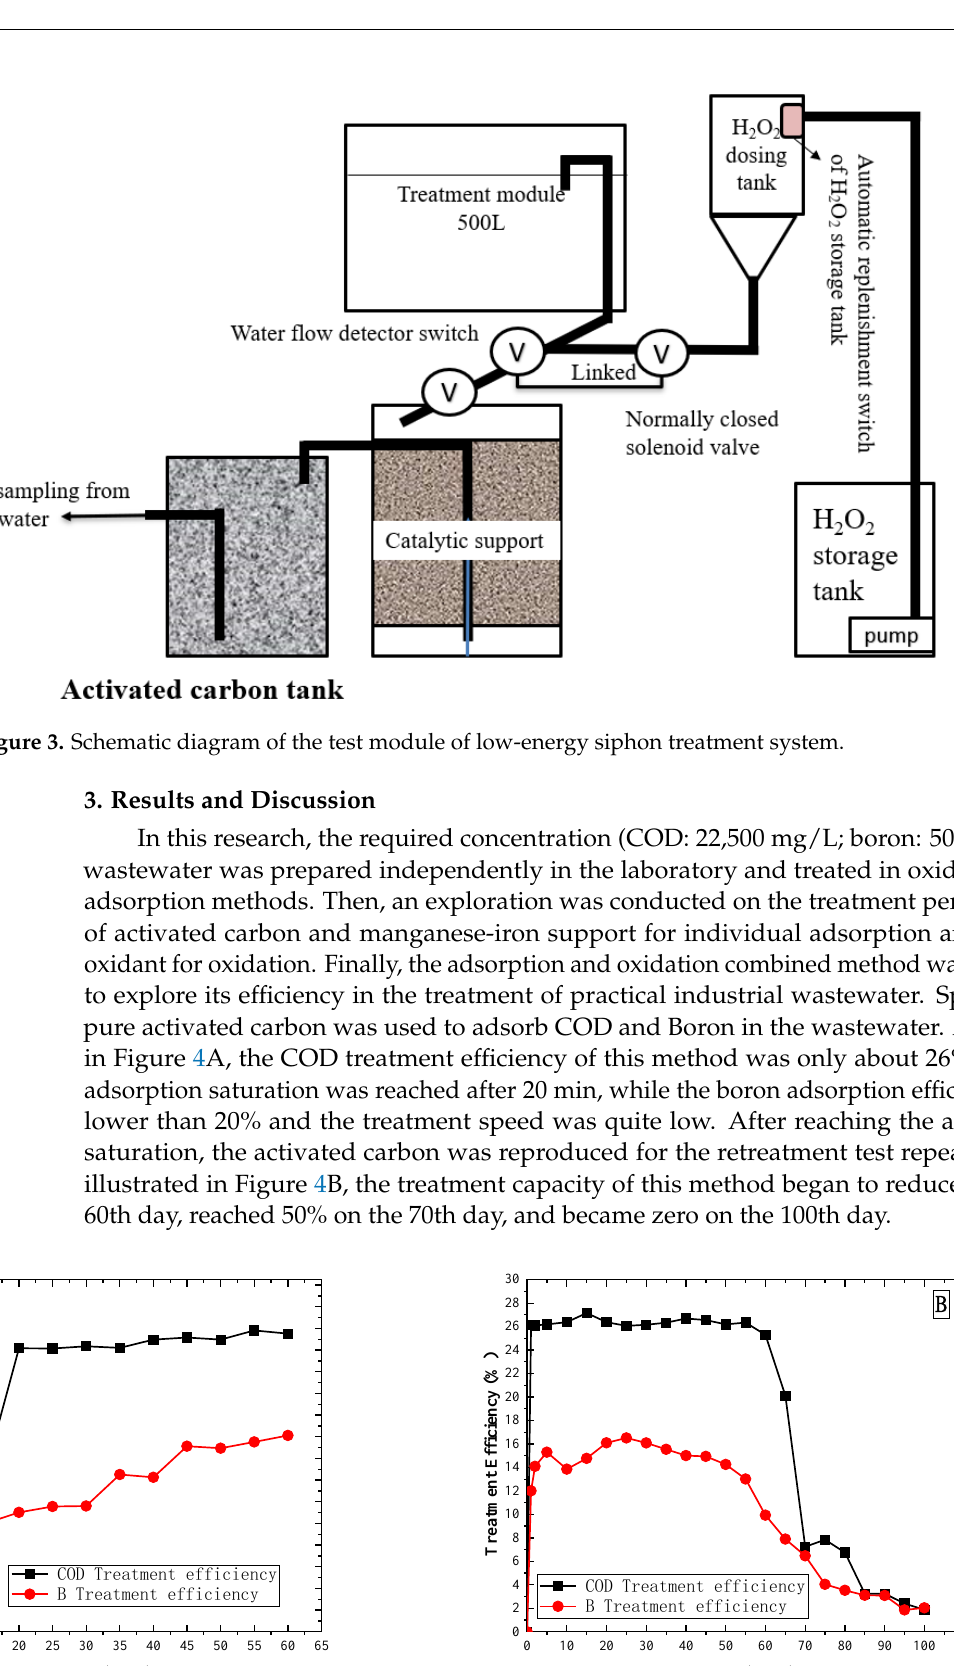
Figure 2. Schematic diagram of the laboratory pipe string test module.